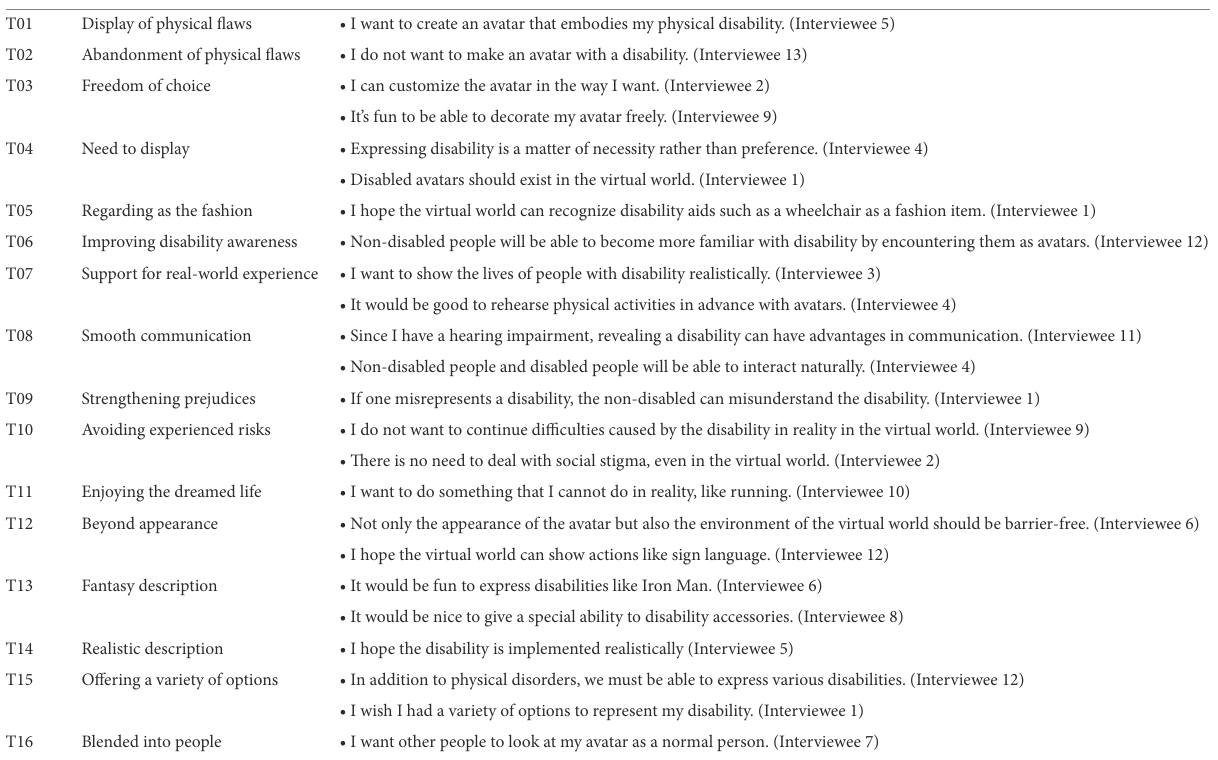
TABLE 2 Topics related to avatar-based disability representations.